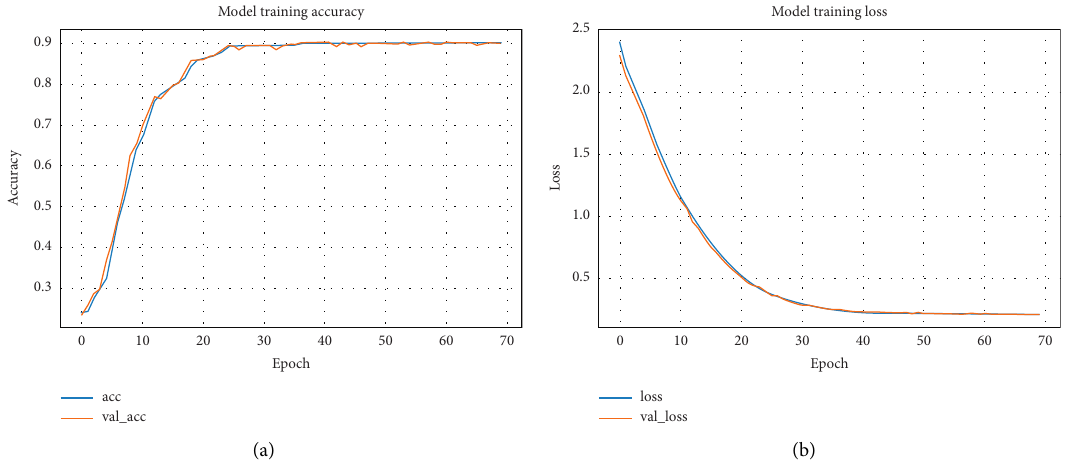
Figure 5: Training statistics on the first-order Markov chain.